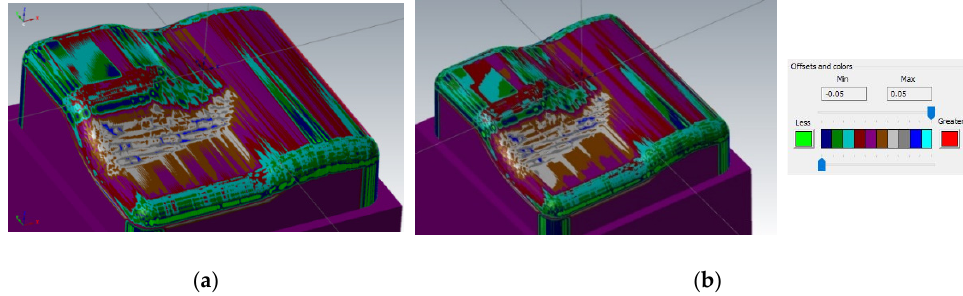
Figure 16. Comparison of CAD model (Inventor) and prediction of milled surface errors using 3-axis milling (Mastercam).